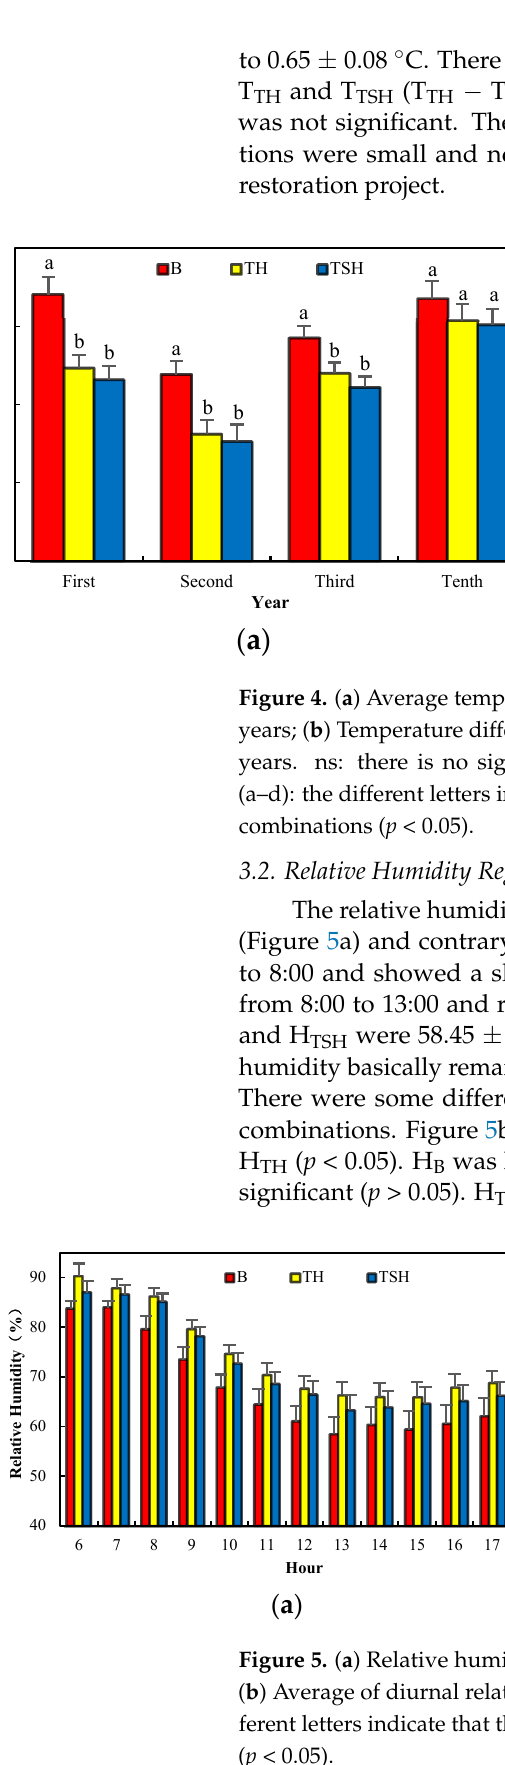
Figure 5. ( a ) Relative humidity variations for each hour in different vegetation type combinations; ( b ) Average of diurnal relative humidity in different vegetation type combinations. (a,b,ab): the dif- ferent letters indicate that there is a significant difference between two vegetation type combinations ( p < 0.05). Figure 6a shows that the relative humidity among different vegetation type combi- nations increased with increasing restoration years and that the relative humidity differ- ence declined. H B was always lower than H TH and H TSH . There was a significant difference